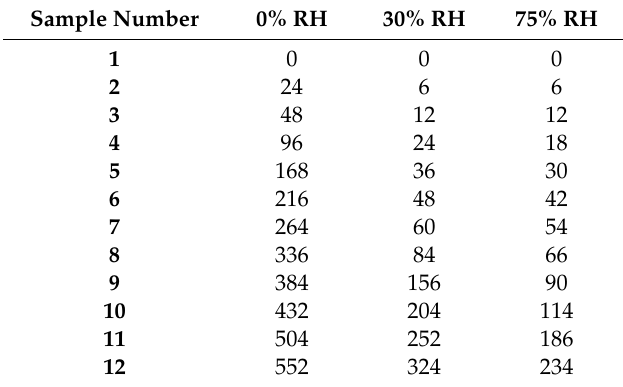
Table 1. Sampling time (h) by relative humidity (RH).